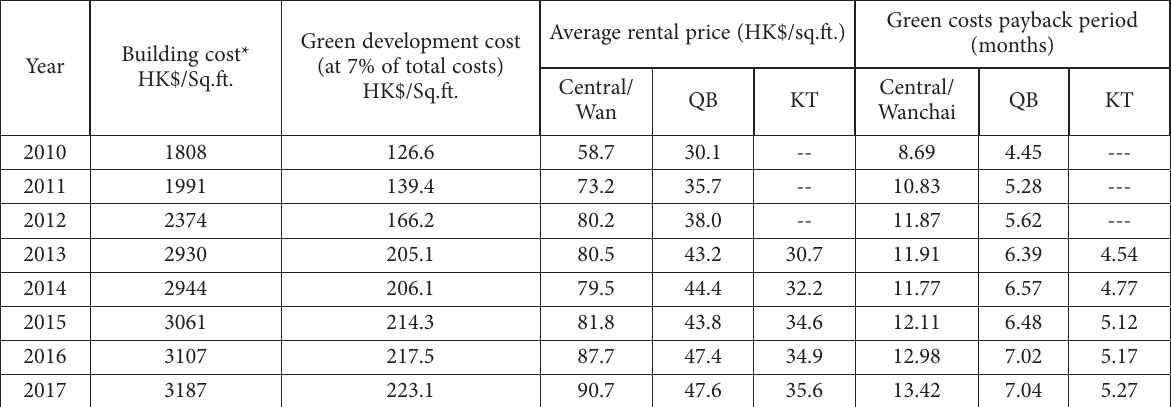
Table 7. Green costs payback period (sources: (a) Cost data from Langdon and Seah (2018), “Quarterly construction cost review”, various issues; (b) Rental data from “Hong Kong Property Reviews”, Hong Kong Rating and Valuation Department (n.d.), various issues) Average rental price (HK$/sq.ft.) Green development cost Building cost* (at 7% of total costs) Year HK$/Sq.ft. HK$/Sq.ft.